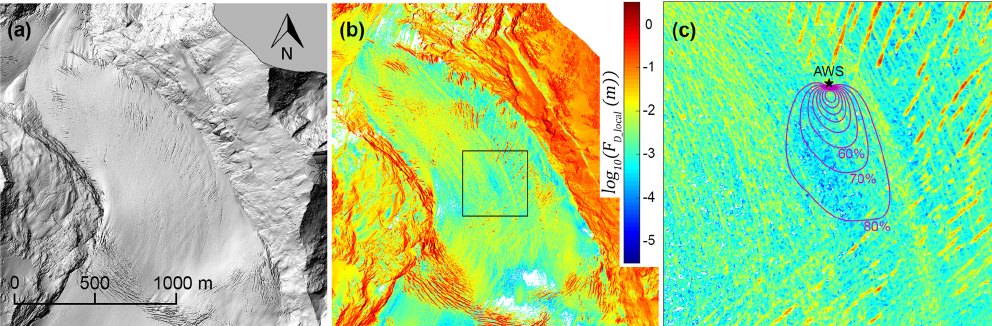
Figure 8. Example from CG16-1 of the steps taken to estimate z 0v_bloc from lidar data: (a) 2000 × 2000m subarea extracted from the 1 × 1m DEM, centred on an AWS; (b) localised drag values ( F D_local ) calculated for each grid cell; (c) the flux footprint for the corresponding EC data, shown as a percentage of crosswind integrated flux contribution (purple contours) and overlaid over the F D_local map (400 × 400m square area expanded from panel (b) for display